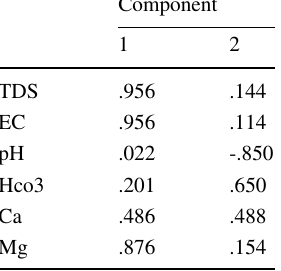
Table 8 The parameters in the